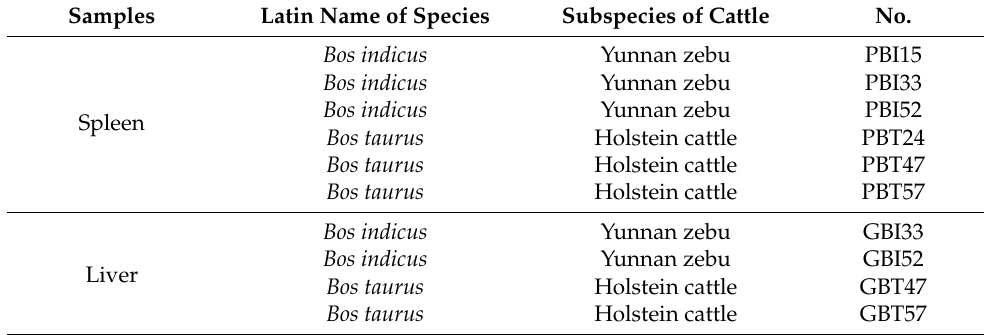
Table 1. Details of the